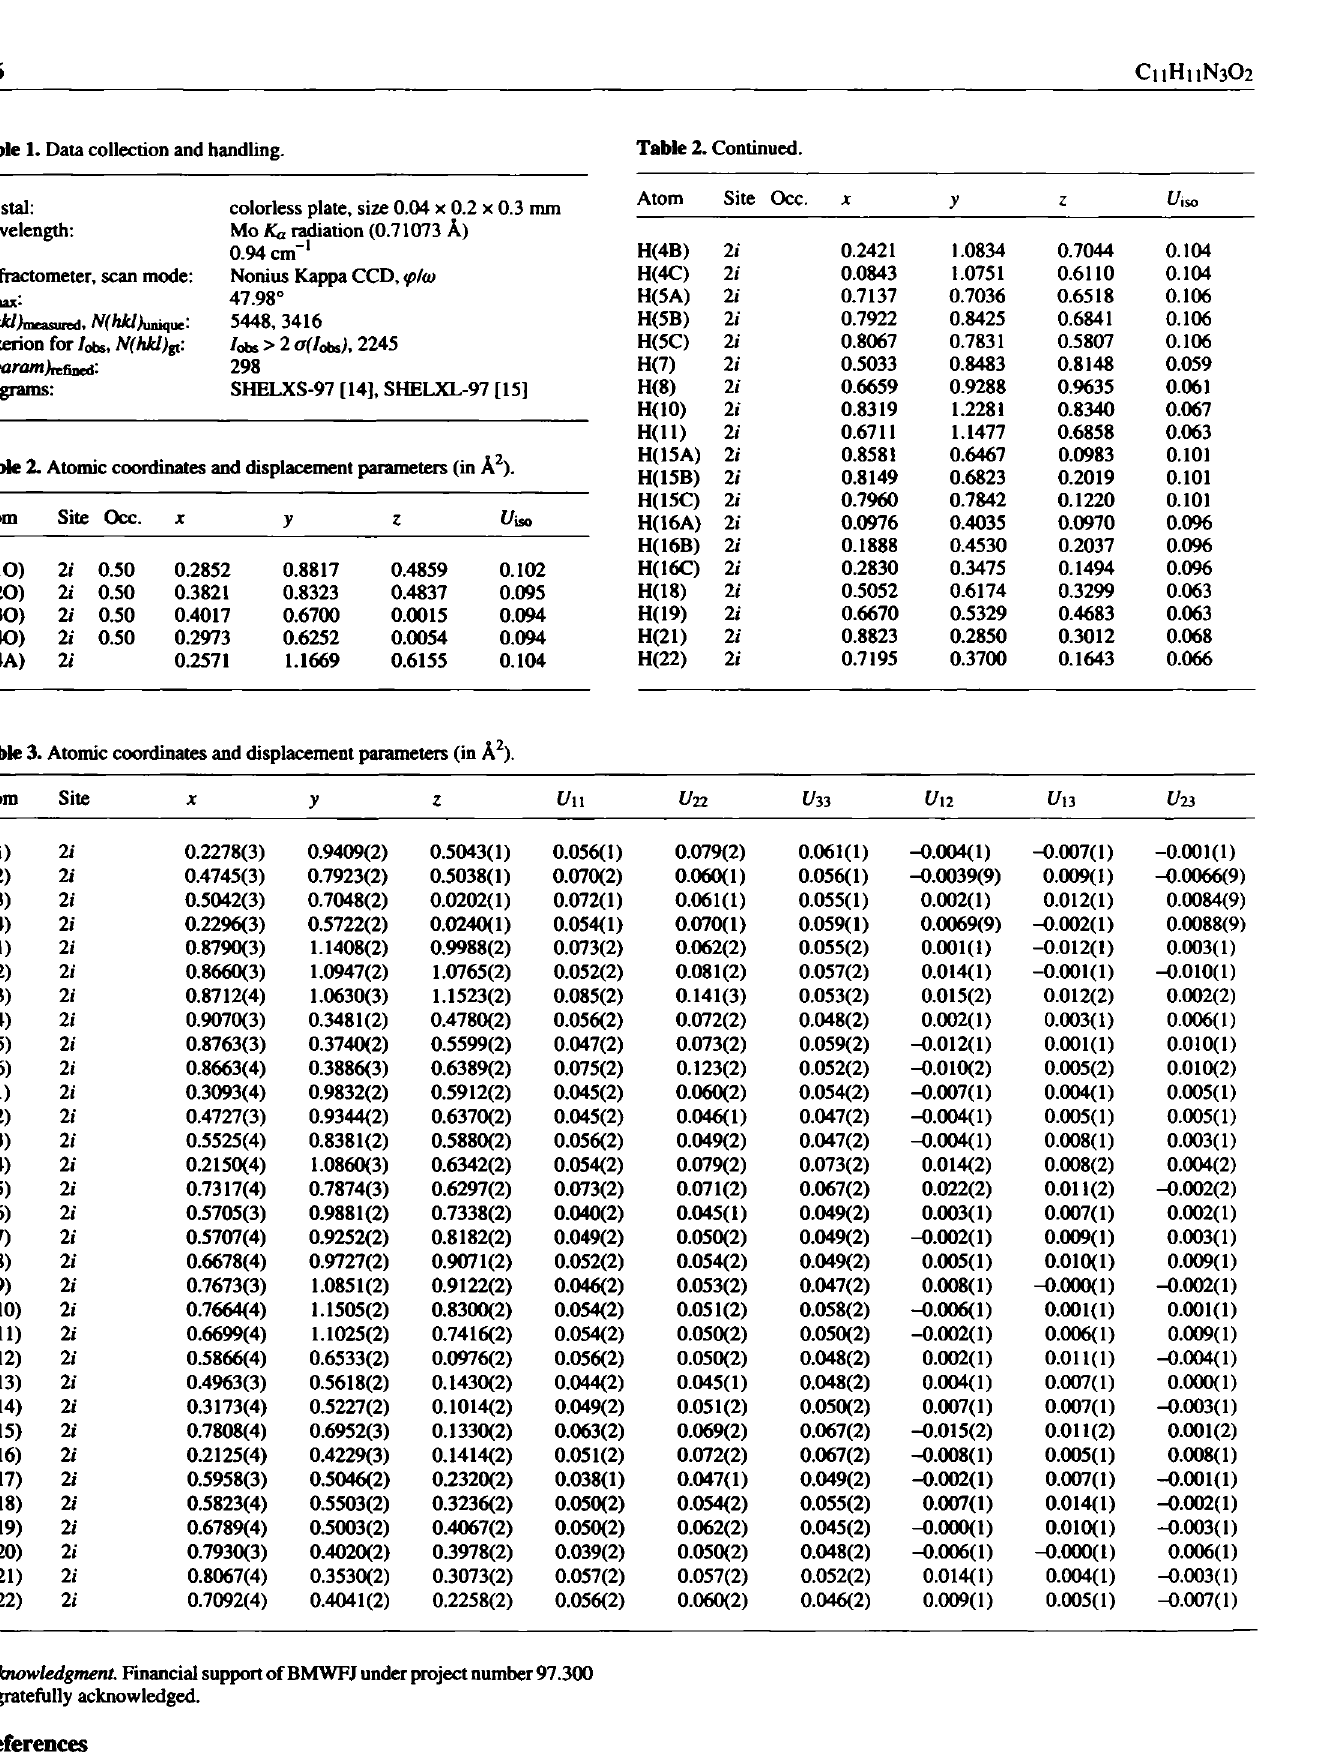
Table 1. Data collection and handling.